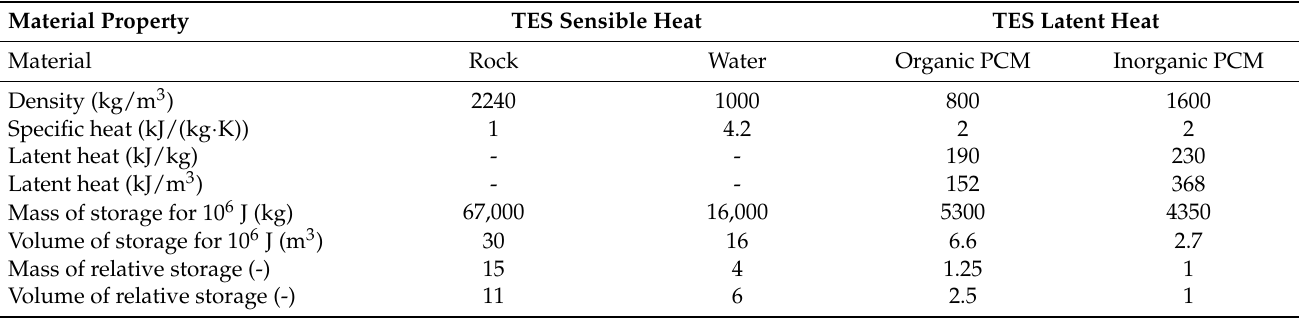
Table 2. Comparing the sensible and latent heat of TES materials for 15 K temperature increase and 300 kWh energy storage